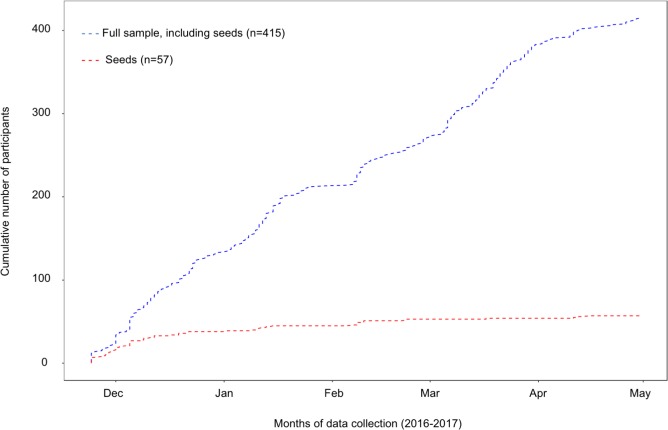
Cumulative number of participants and seeds over the course of data collection.